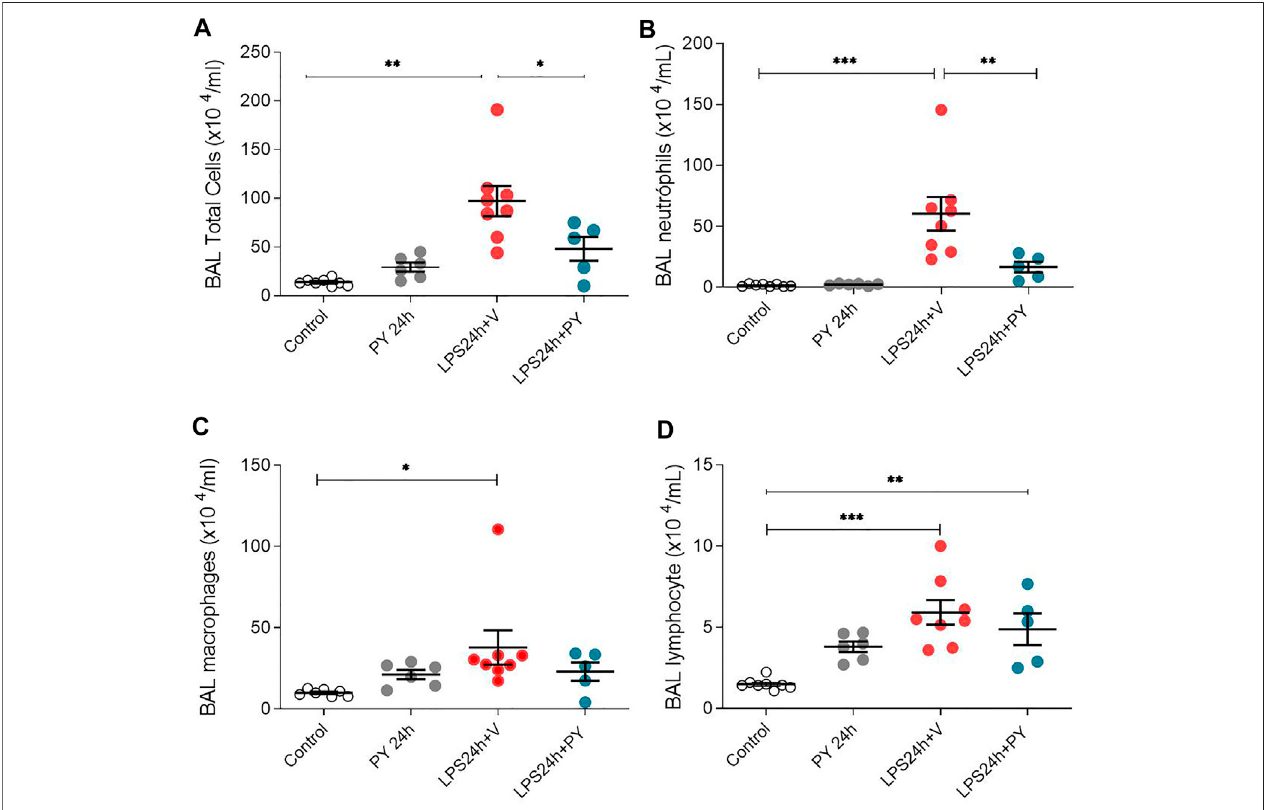
FIGURE 1 | Pyridostigmine reduces BAL immune/in fl ammatory cell numbers in LPS exposed mice at 24 h. (A) BAL total cells (B) neutrophils, (C) macrophages, and (D) lymphocytes. Vehicle (V) group (Control), pyiridostigmine (PY), lipopolysaccharide (LPS) *** p < 0.001, ** p < 0.01 and * p < 0.05. Values expressed as mean ± SEM. One-way ANOVA followed by Tukey ’ s test (See text for